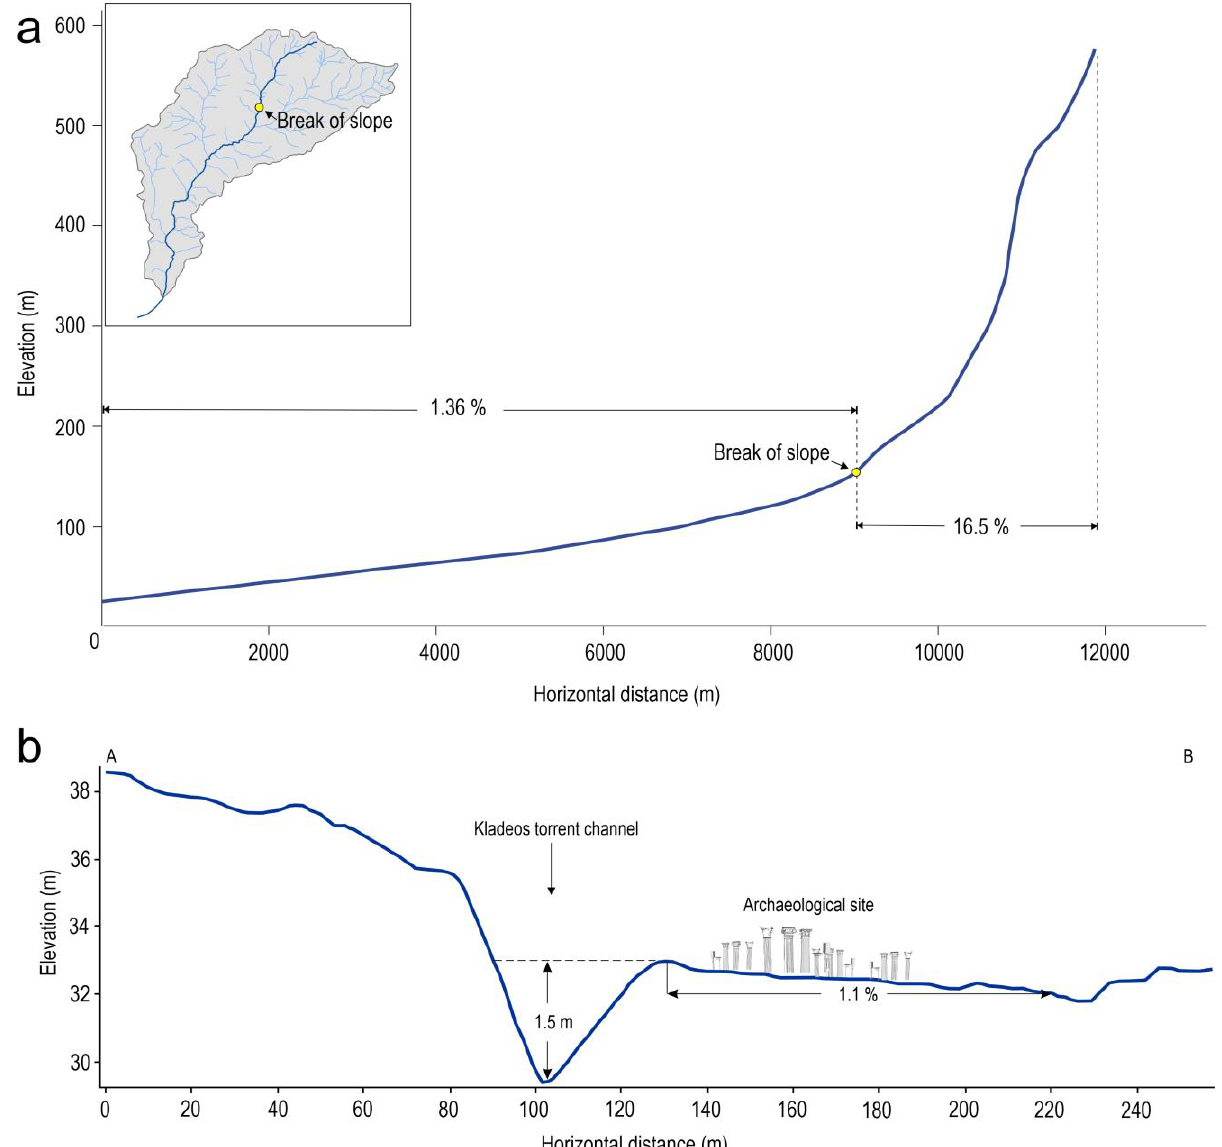
Figure 6. ( a ) Longitudinal profile along the main channel of the Kladeos River. ( b ) Cross section at the lower reaches of the main channel. The location of the cross section is depicted in Figure 1.